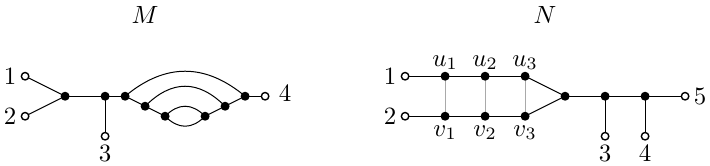
Figure 3: A network M with a 3 -burl and a sorted 3 -handcuffed caterpillar N .